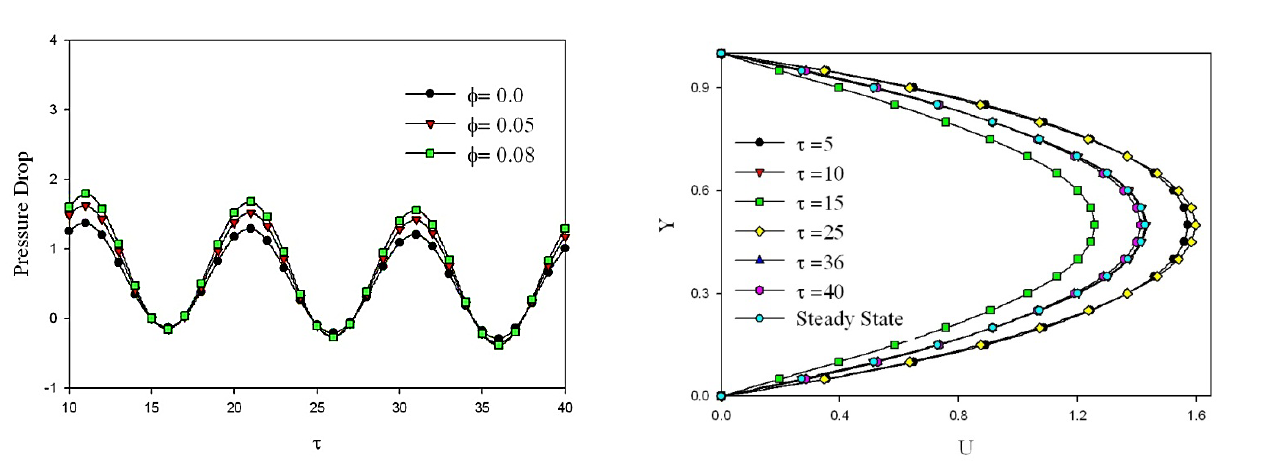
Fig. 14. Distribution of the horizontal velocity for = 0.1. different dimensionless time at X= 8.5, Y=0.45, Re=100, 0 A =0.05, 0.01 φ = and 0